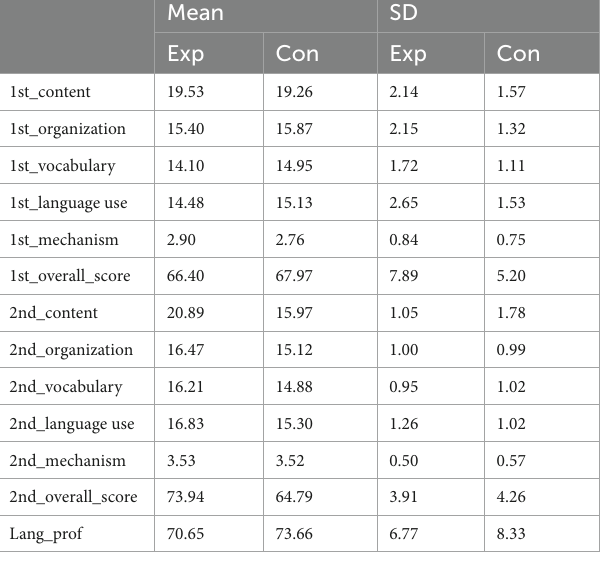
TABLE 3 Descriptive statistics of writing